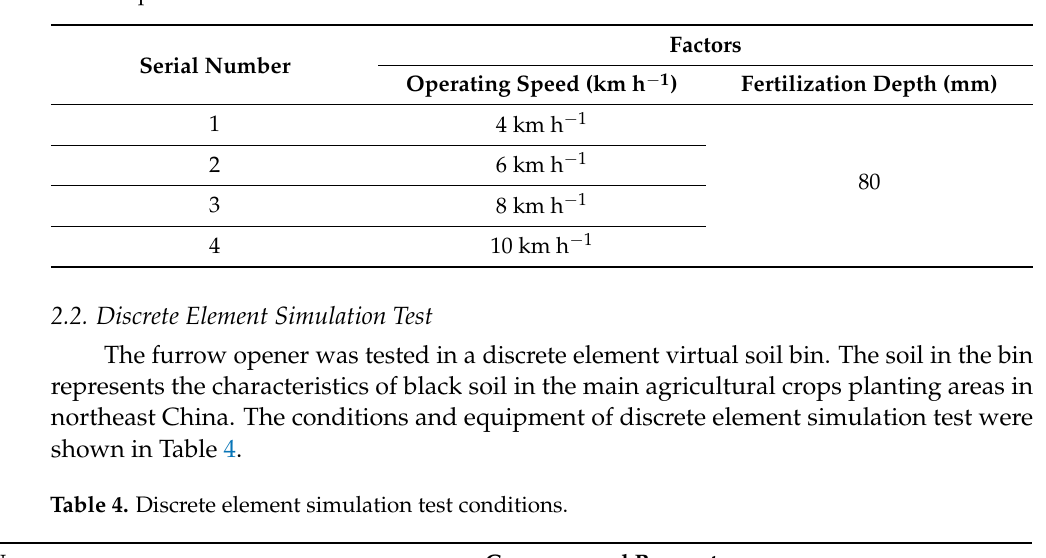
Table 3. Factors of bionic sturgeon liquid fertilizer deep application furrow opener and core-share furrow opener.